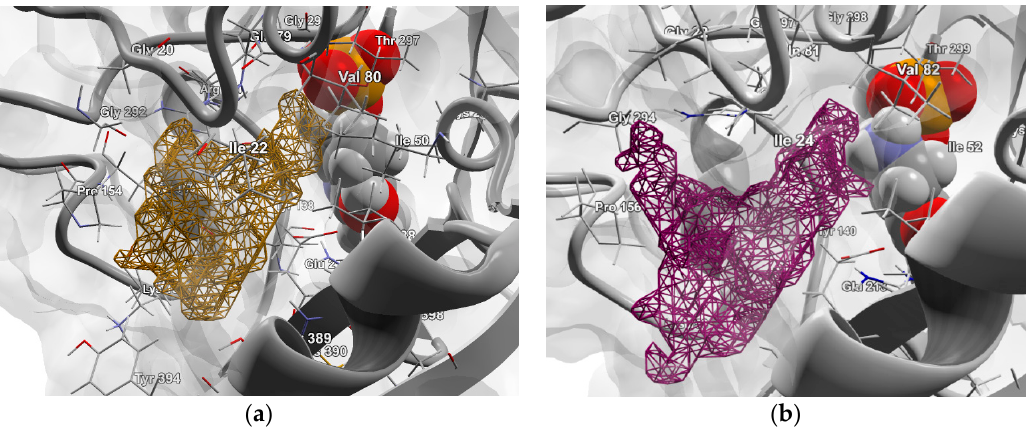
Figure 6. ( a ) GABA-AT catalytic site cavity (in orange color) of Escherichia coli (PDB: 1SF2); ( b ) GABA-AT catalytic site cavity (in purple color) of Pseudomonas model. The cofactor (PLP) is represented as gray, blue, orange and red color Van der Waals spheres.